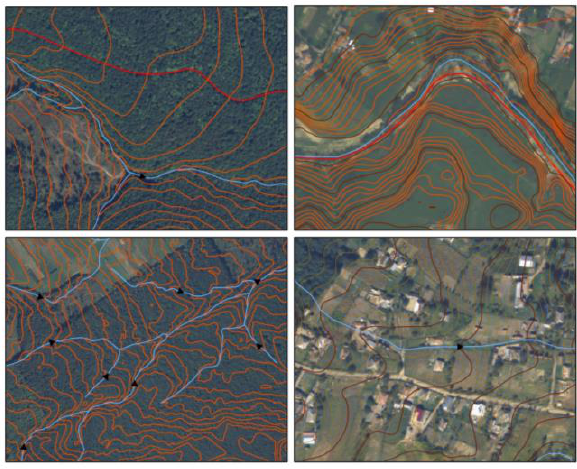
Figure 1. Photo interpretation from 2D and 3D data sources Furthermore, the running water vectors are only X, Y and when their track does not meet the relief, any further transformation to 3D space system is affected by errors.